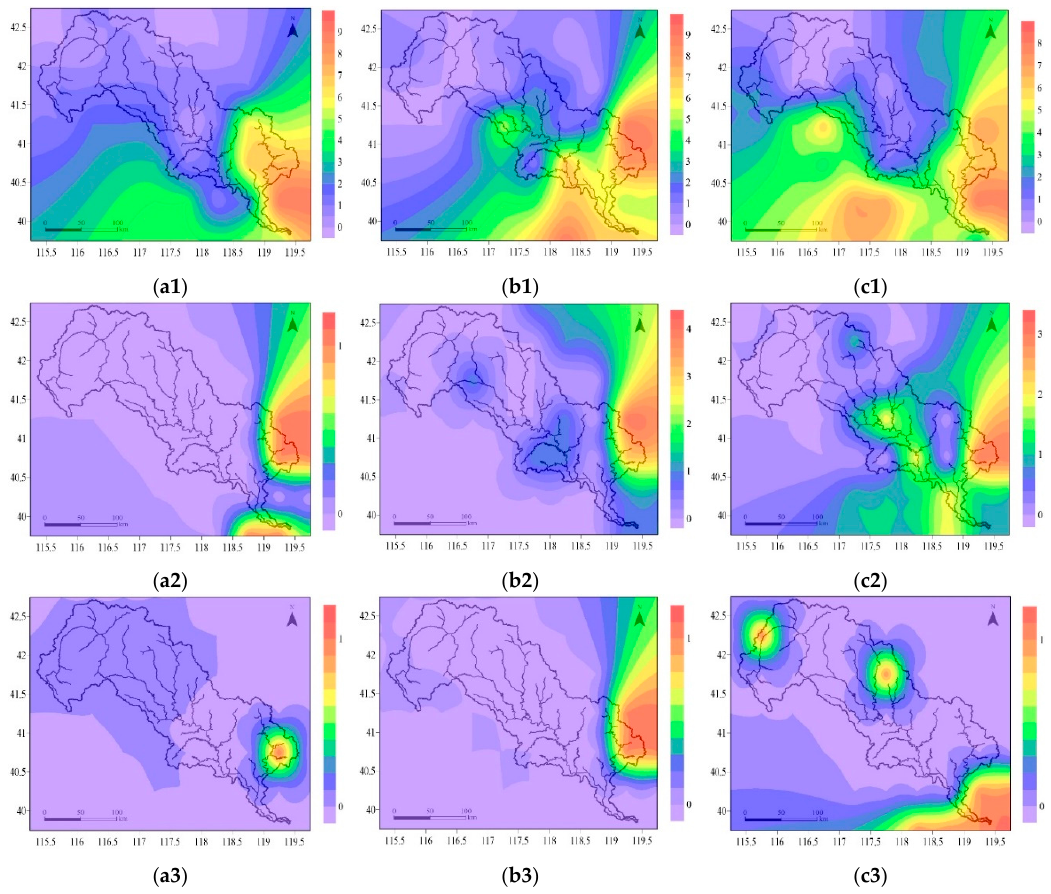
Figure 5. Distribution of drought–flood abrupt alternation events, from 2020 to 2050, in the Luanhe River Basin: In light level under RCP2.6 ( a1 ), RCP4.5 ( b1 ) and RCP8.5 ( c1 ); in moderate level under RCP2.6 ( a2 ), RCP4.5 ( b2 ), and RCP8.5 ( c2 ); in severe level under RCP2.6 ( a3 ), RCP4.5 ( b3 ), and RCP8.5 ( c3 ). RCPs represents the representative concentration pathways. The color bars represent the occurrence frequency of drought–flood abrupt alternation events, for example, the purple means the frequency is zero.